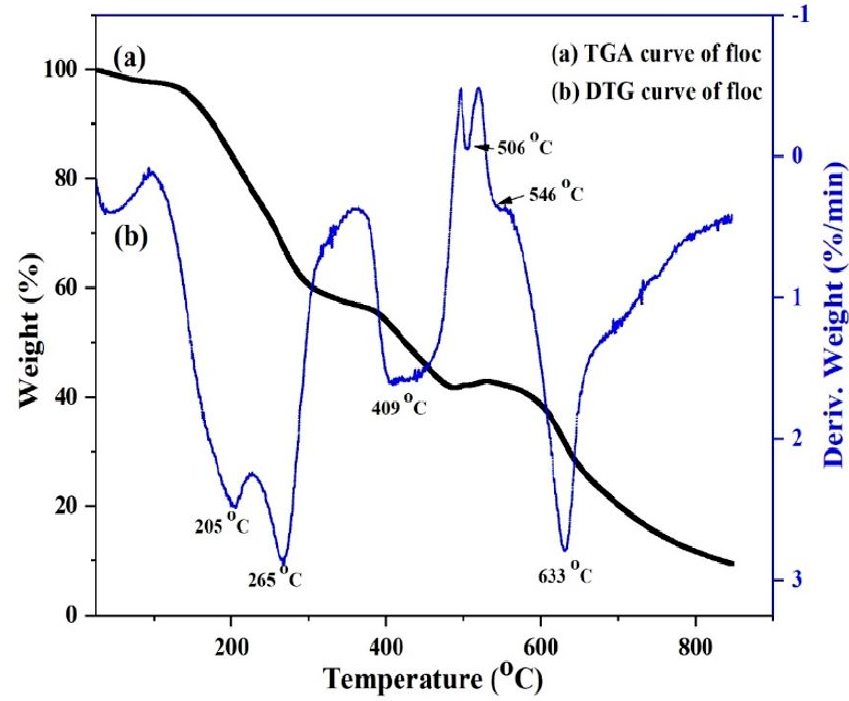
Figure 5. TGA and DTG spectra of the NOCNF-Tl floc (0.32 wt% NOCNF with 300 ppm Tl(I)).